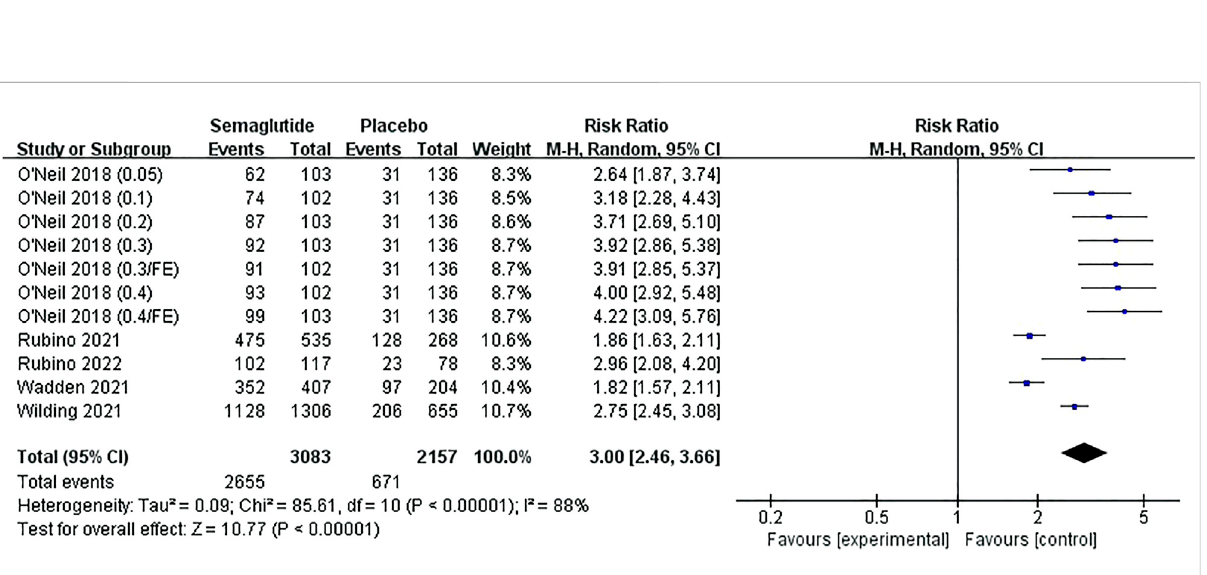
FIGURE 7 Meta-analysis results of the proportion achieving 5% weight loss in included